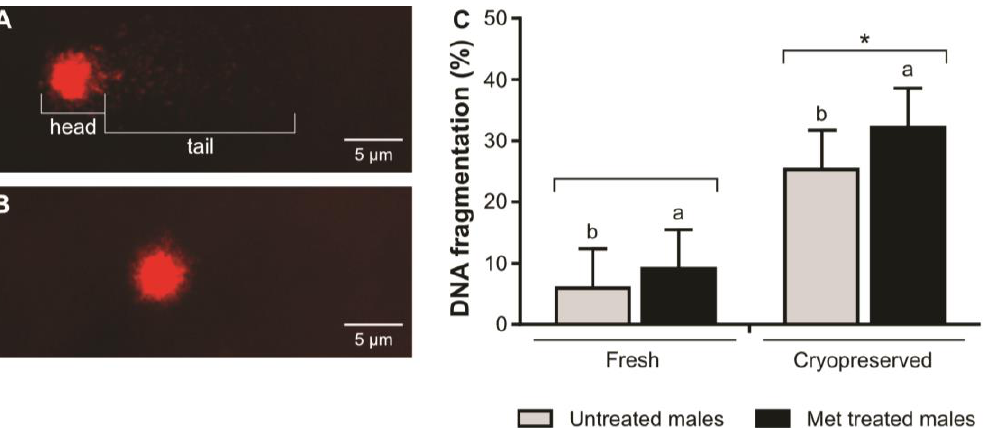
Figure 5. DNA integrity in zebrafish sperm: ( A ) comet with high DNA fragmentation; ( B ) comet with low DNA fragmentation; ( C ) DNA fragmentation of fresh sperm obtained from untreated Tg( ins : nfsb-mCherry ) males ( n = 4) and metronidazole (Met)-treated males ( n = 8) and of cryopreserved sperm from untreated males ( n = 5) and Met-treated males ( n = 6). The plotted values represent means ± SD. Different letters represent statistical differences between treatments and the asterisk represents a statistical difference between fresh and cryopreserved sperm (independent samples t -test, p < 0.05).